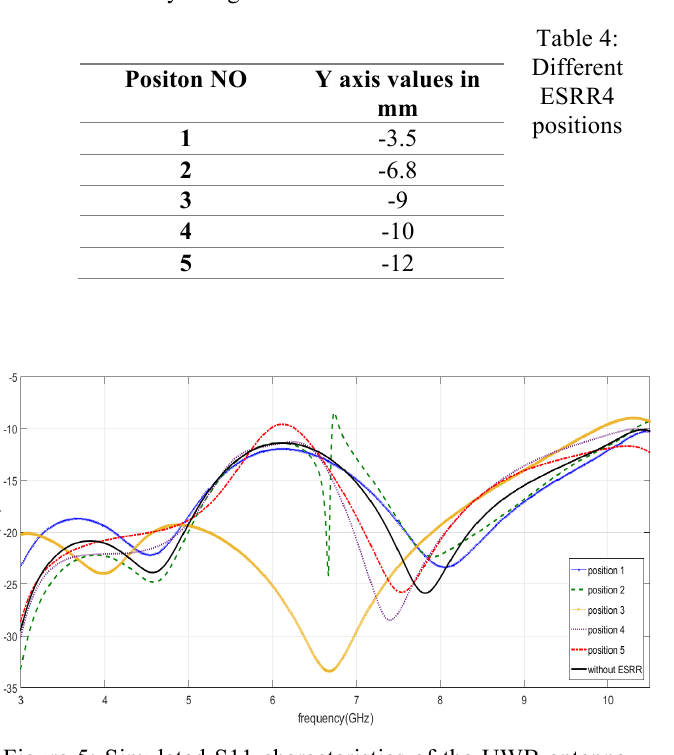
Figure 5: Simulated S11 characteristics of the UWB antenna with ESRR4 only using HFSS.